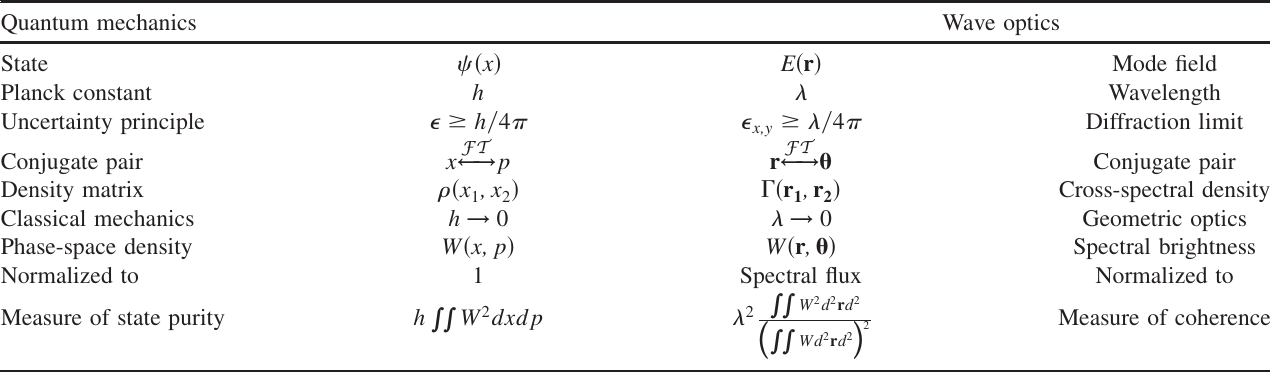
TABLE I. Correspondence between quantum and optical